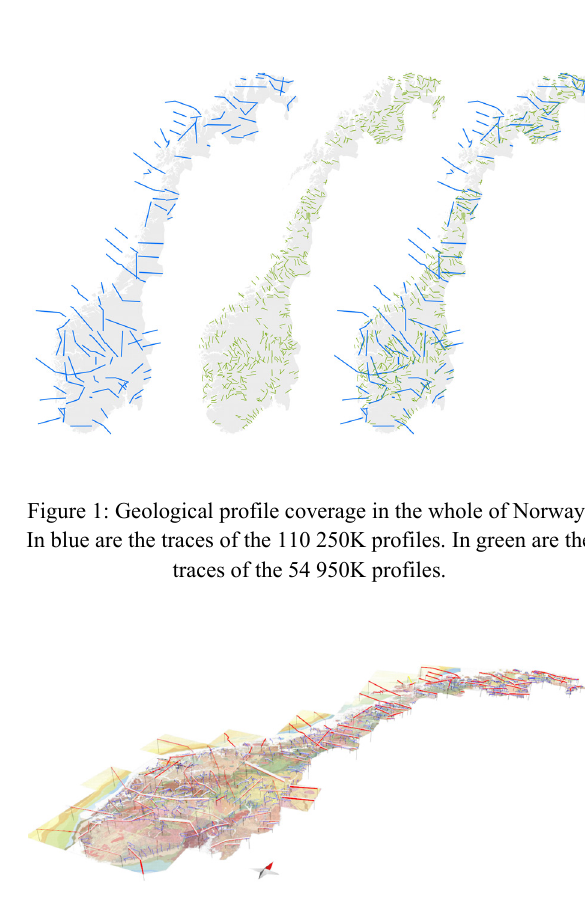
Figure 2: The 50-250K geological profile traces, the 3D georeferenced geological profiles and the surface bedrock data loaded into 3D MOVE. View from the SE.